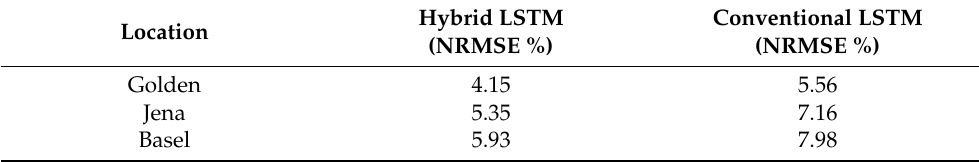
Table 6. A performance comparison of the hybrid and conventional LSTM